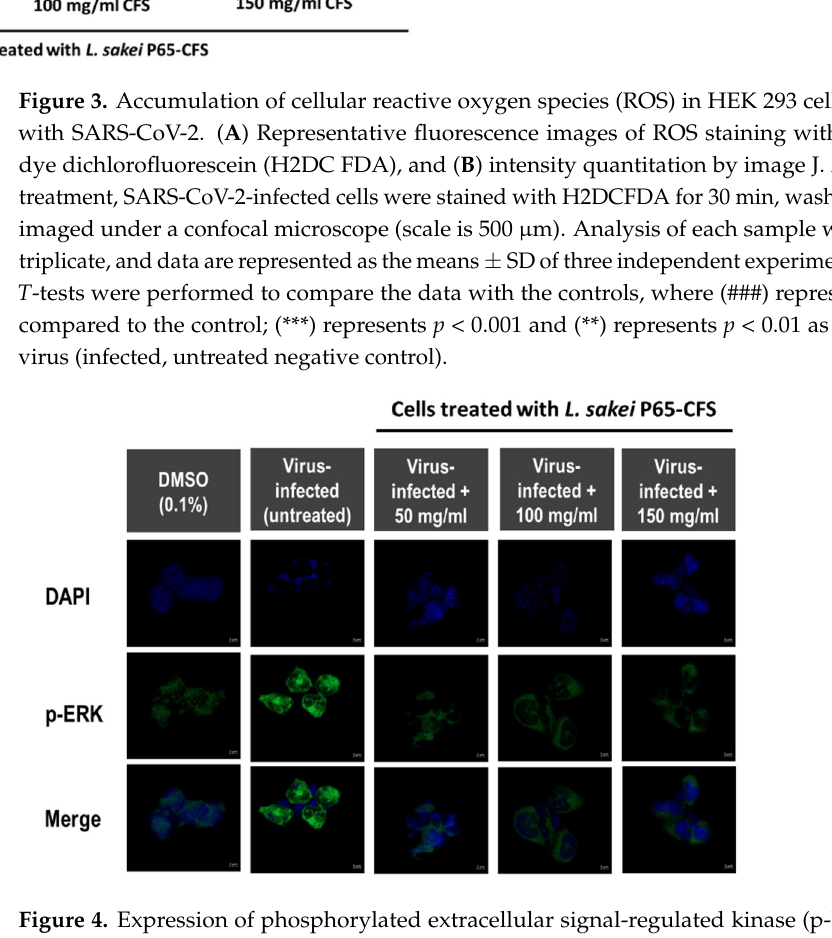
Figure 3. Accumulation of cellular reactive oxygen species (ROS) in HEK 293 cells upon infection with SARS ‐ CoV ‐ 2. ( A ) Representative fluorescence images of ROS staining with the fluorogenic dye dichlorofluorescein (H2DC FDA), and ( B ) intensity quantitation by image J. At the end of the treatment, SARS ‐ CoV ‐ 2 ‐ infected cells were stained with H2DCFDA for 30 min, washed with PBS, and imaged under a confocal microscope (scale is 500 μ m). Analysis of each sample was performed in triplicate, and data are represented as the means ± SD of three independent experiments. Independent T ‐ tests were performed to compare the data with the controls, where (###) represents p < 0.001 as compared to the control; (***) represents p < 0.001, (**) represents p < 0.01 and (*) represents p < 0.05 as compared to the virus (infected, untreated negative control).